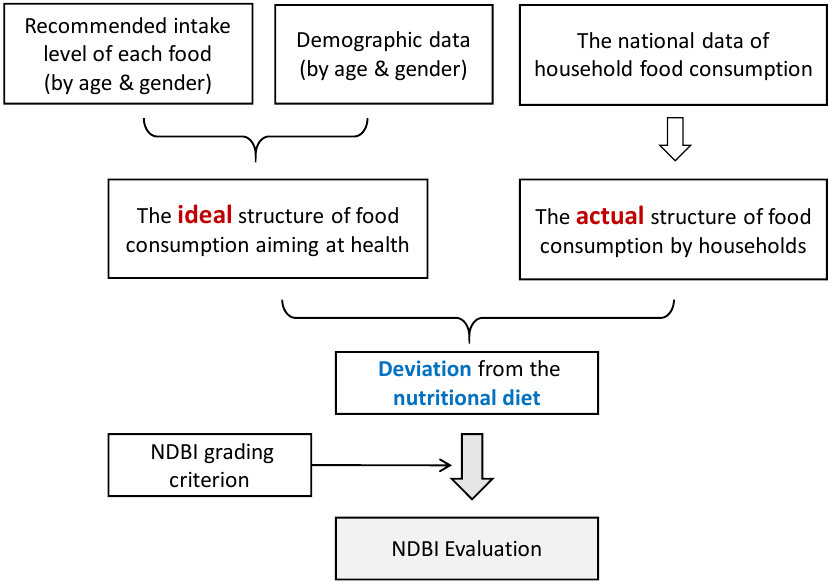
Figure 1. Structural flow diagram of evaluating National Diet Balance Index